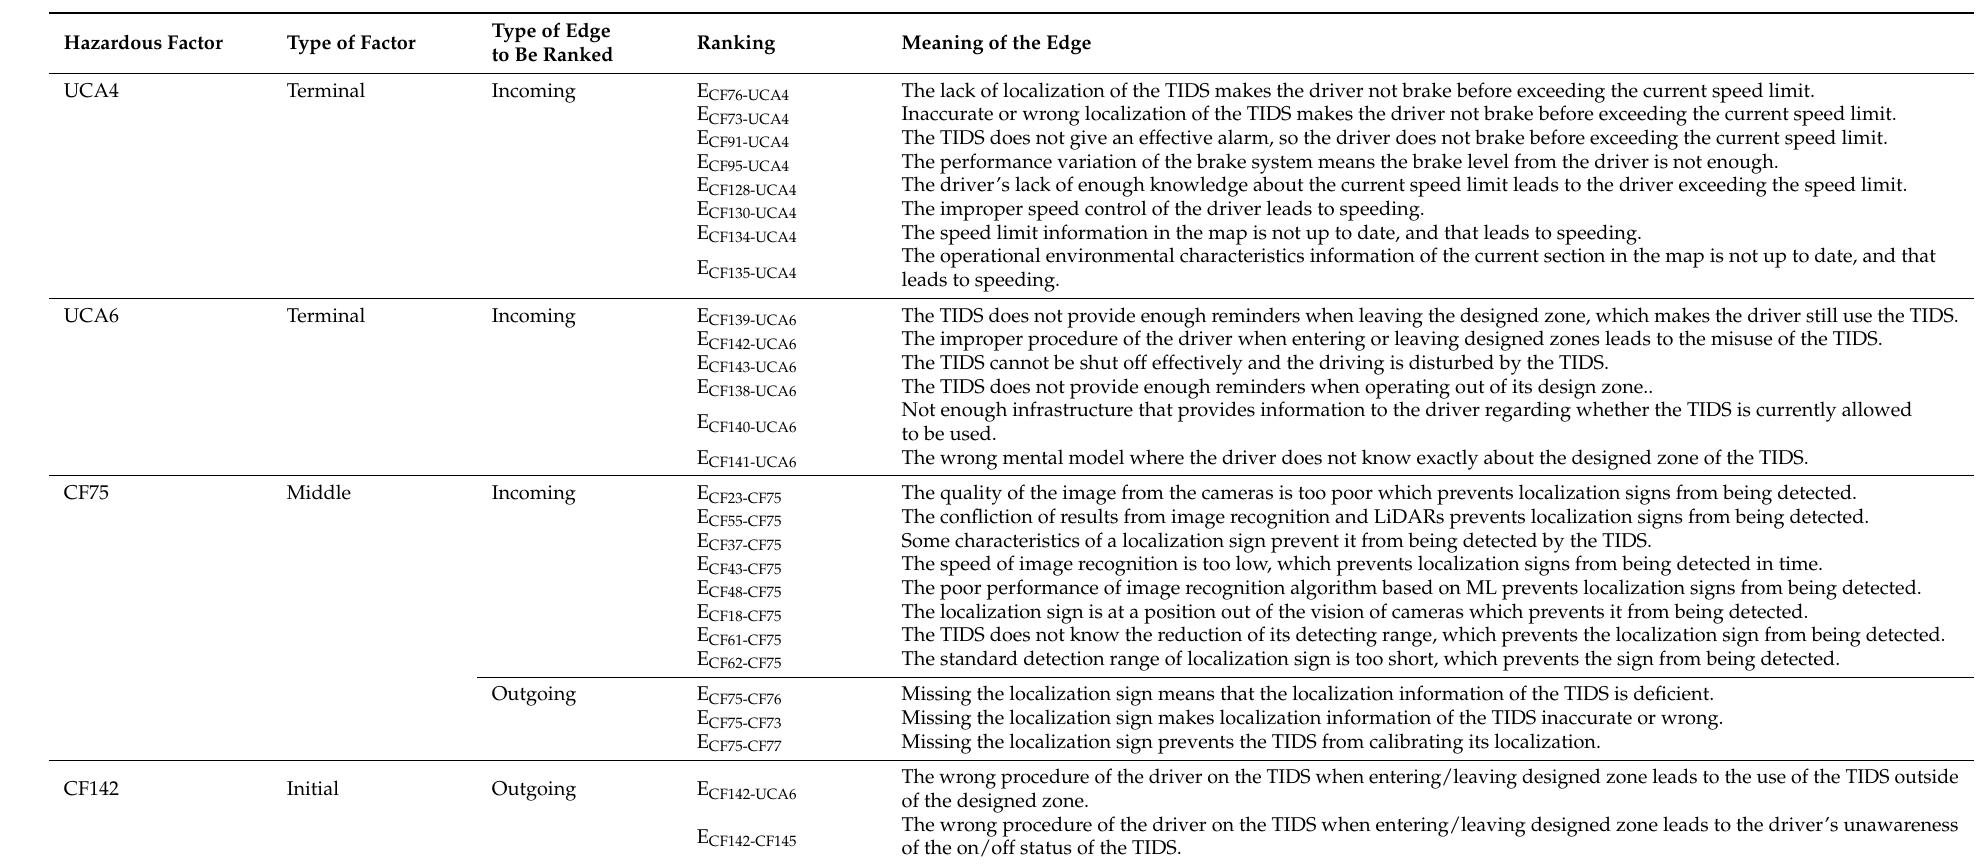
Table 3. The ranking of edges of some hazardous factors based on edge importance